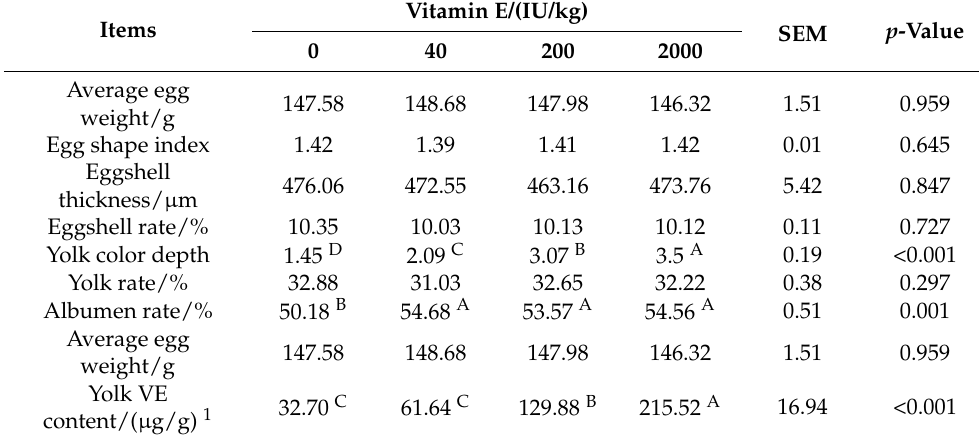
Table 5. Effects of dietary vitamin E supplementation on egg characteristics in breeding geese. Items